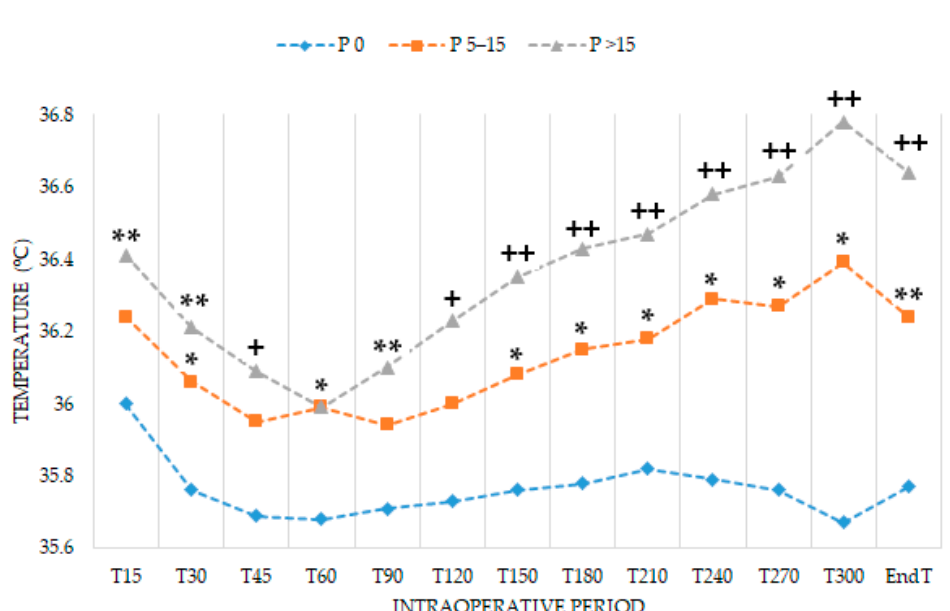
Figure 1. Mean perioperative temperature (°C) in each group. PreT: temperature upon arrival at the pre-anesthesia room; EndT: temperature at the end of surgery; P 0: non-pre-warmed; P 5–15: pre-warmed for 5–15 min; P > 15: pre-warmed for 15–30 min. * p < 0.05 vs. P 0; ** p < 0.01 vs. P 0; + p < 0.001 vs. P 0; ++ p ≤ 0.0001 vs. P 0.